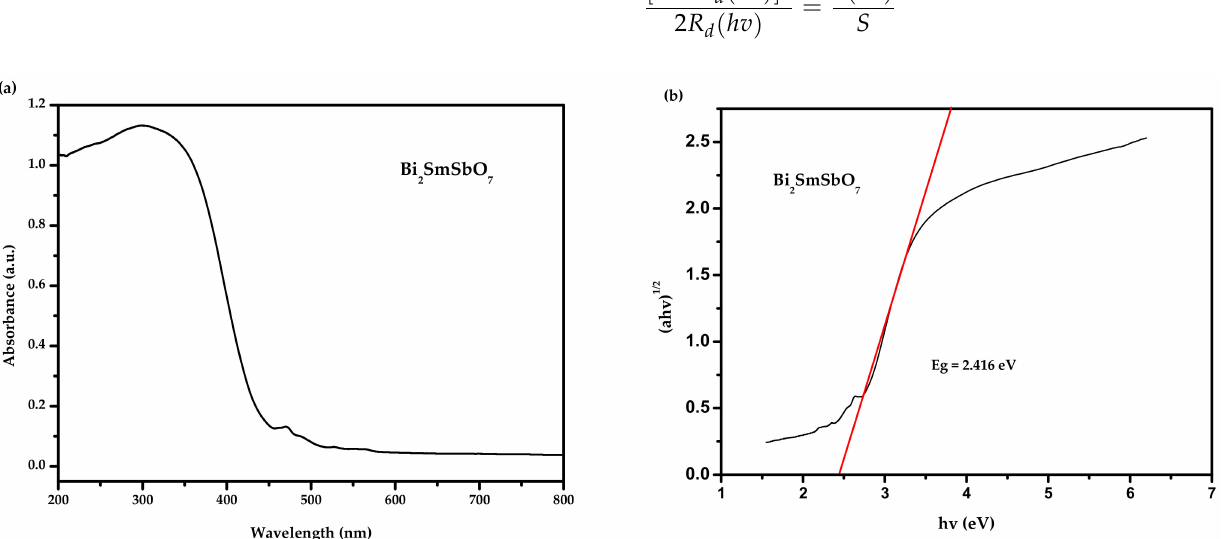
Figure 4. ( a ) The diffused reflection spectrum of Bi 2 SmSbO 7 ; ( b ) Correlative diagram of ( α h ν ) 1/2 and h ν for Bi 2 SmSbO 7